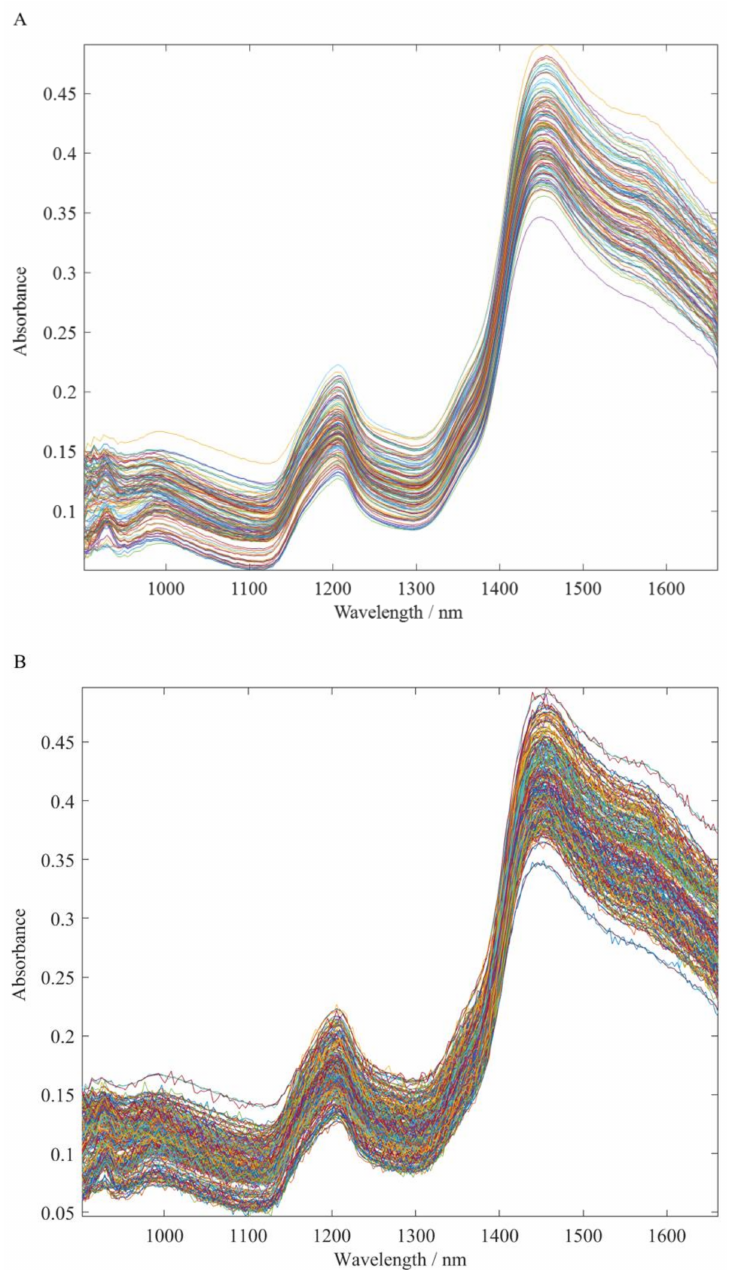
Figure 1. NIR spectra ( A ) and the NIR spectra by data augmentation ( B ) of all